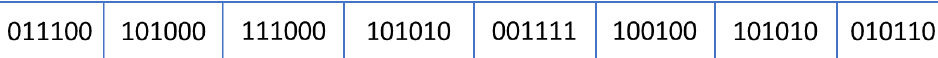
Figure 2. Representation of an individual with eight genes constructed according to the peculiarities of DUT in question.